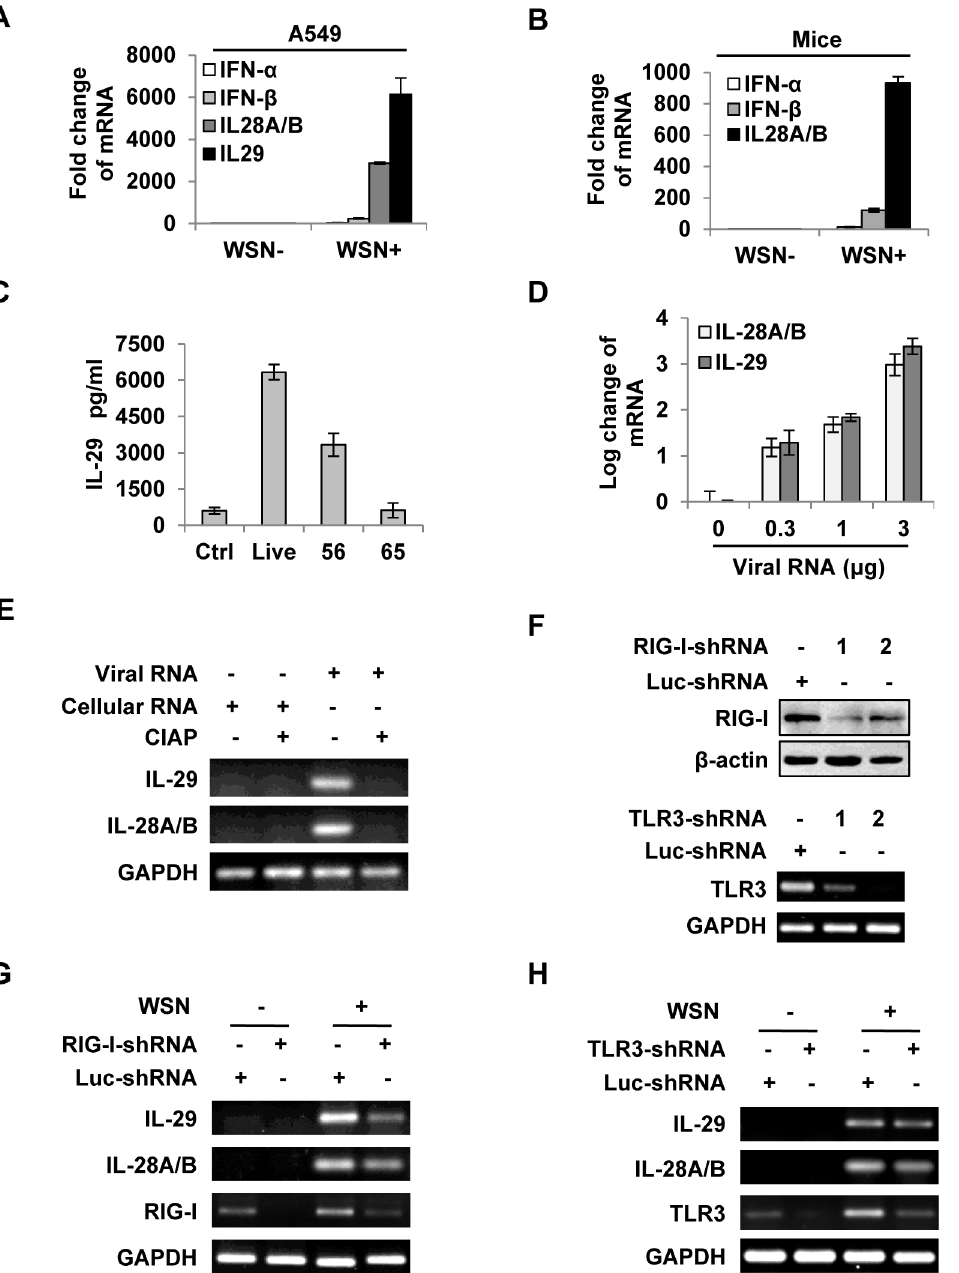
Fig 1. IAV infection induces robust expression of IFN- λ in alveolar epithelial cells mainly through a RIG-I-dependent pathway. (A) A549 cells infected with or without WSN virus (MOI = 1) for 15 h, mRNA levels of IFN- α , β and λ were examined by real-time PCR. (B) BALB/c mice were infected intranasally with or without WSN virus (1×10 5 PFU). On day 3 p.i., lungs were lysed, and the mRNA levels of IFN- α , β and λ were examined by real-time PCR. (C) A549 cells were uninfected (Ctrl) or infected with WSN that was untreated (Live) or treated at 56°C or 65°C. IL-29 levels in supernatants from A549 cells at 15 h p.i. were measured by ELISA. (D) Different amounts of total RNA ( “ Viral RNA ” ) from A549 cells infected with the IAV were transfected into native A549 cells using Lipofectamine 2000 (L2000). Expression of IL-28A/B and IL-29 in transfected A549 cells was examined by real-time PCR at 4 h p.i. (E) “ Viral RNA ” and “ Cellular RNA ” (total RNA from uninfected control A549 cells) treated with or without calf intestine alkaline phosphatase (CIAP) were transfected into native A549 cells. RT-PCR was performed to examine the expression of IL-28A/B and IL-29. (F) shRNA based-knockdown of RIG-I and TLR3 were analyzed by Western blotting or RT-PCR to determine the interference efficiency. (G-H) A549 cells expressing shRNAs targeting RIG-I (G), TLR3 (H) or luciferase (Luc) were infected with or without WSN, and then the expression of IL-28A/B and IL-29 was examined by RT-PCR. Results are representative of three independent